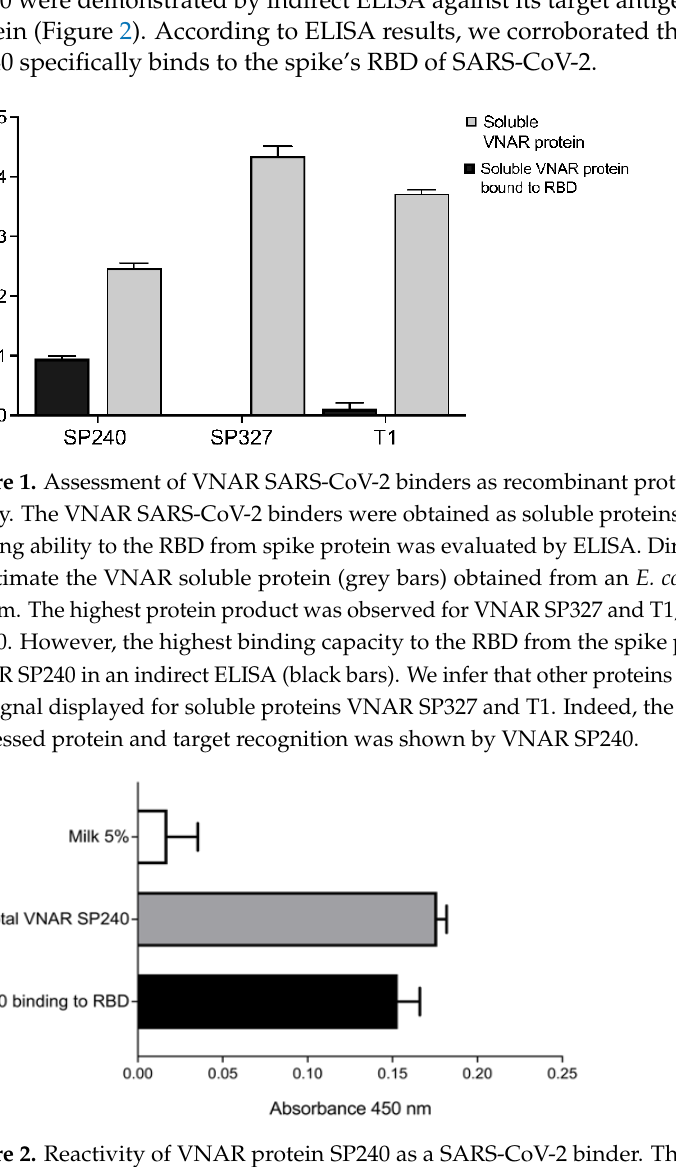
Figure 2. Reactivity of VNAR protein SP240 as a SARS-CoV-2 binder. The purified protein VNAR SP240 was evaluated by ELISA. The amount of total protein of SP240 and binding specificity were interpreted in terms of absorbance at 450 nm. The light grey bar corresponds to the signal displayed by total protein VNAR SP240 obtained after the purification steps. The binding reactivity of the protein VNAR SP240 to the antigen RBD of spike protein was corroborated by indirect ELISA. The black bar corresponds to the signal displayed after the binding of SP240 to RBD of the spike protein. Skim milk 5% was used as a negative control during the assay.